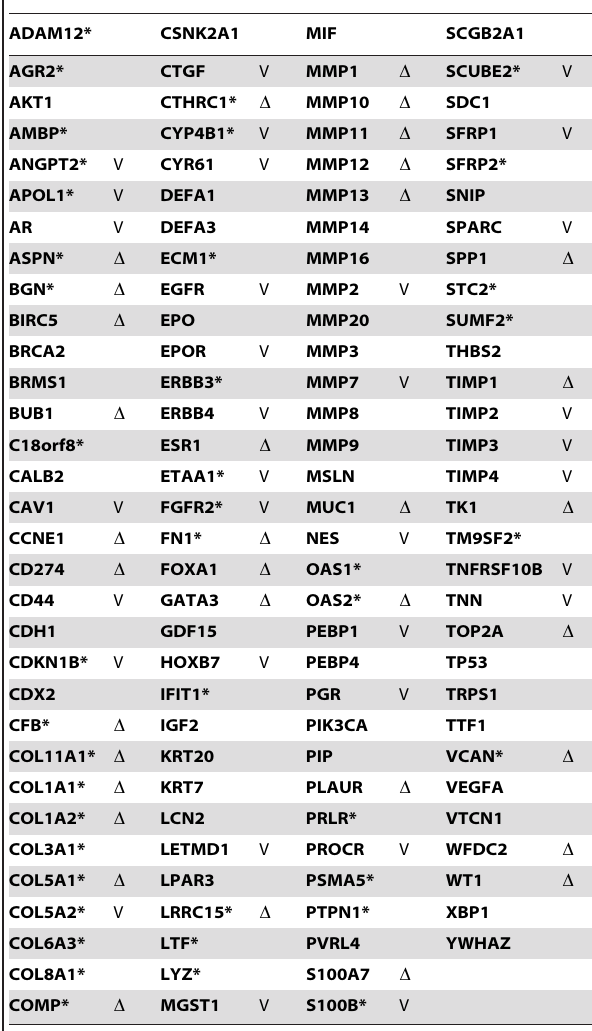
Table 2. 71 of 126 genes discriminate cancers from